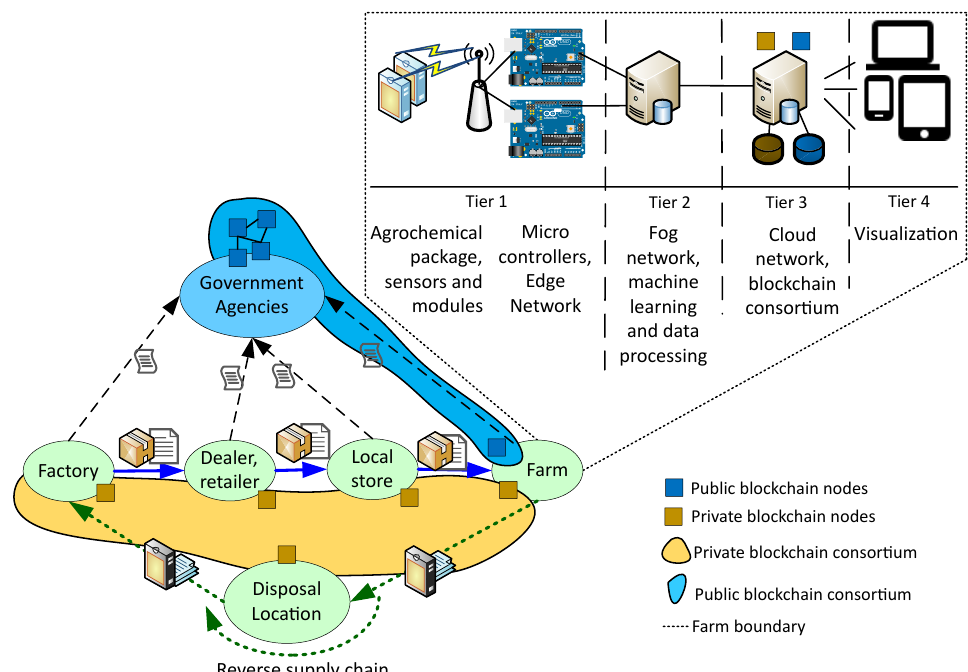
Figure 3. Agrochemicals Pervasive Traceability Model